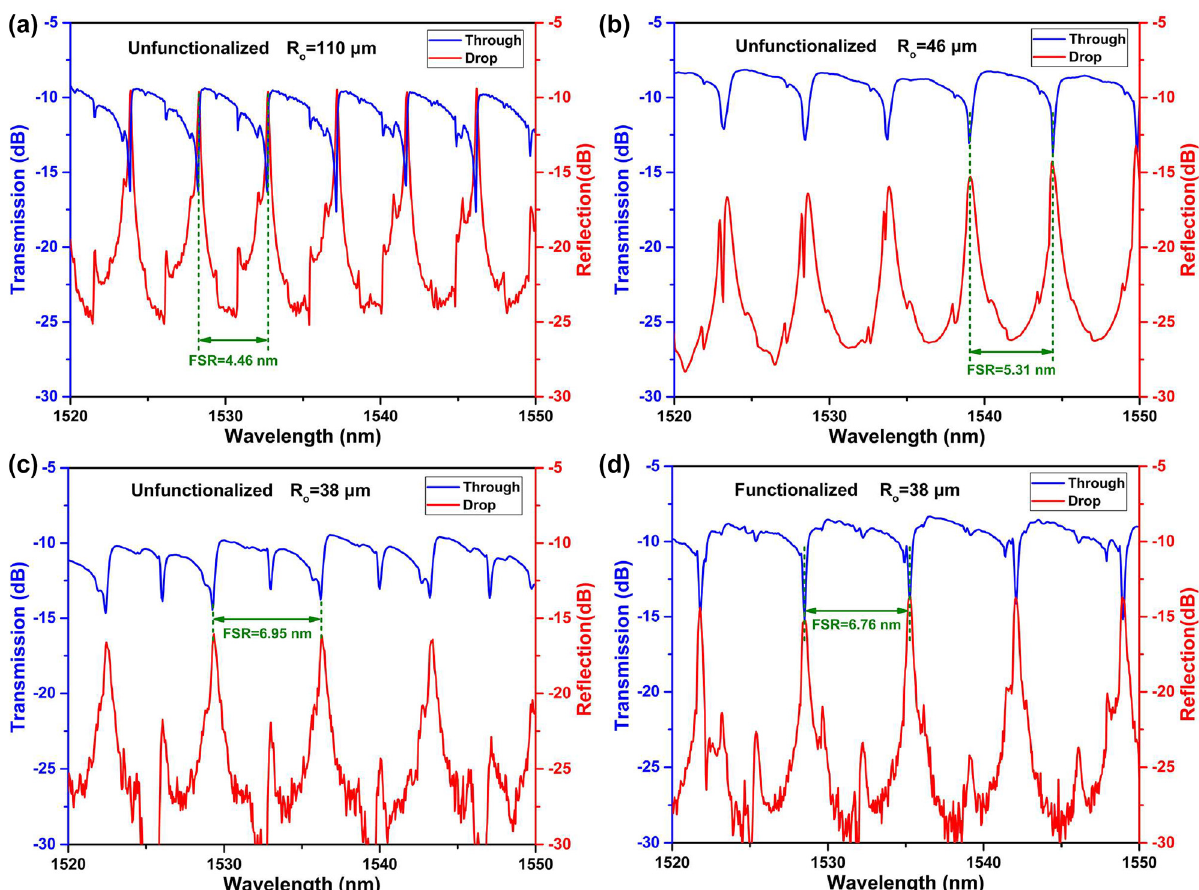
Figure 5: Excitation of WGM in double-fiber-coupled microtubule. Transmission and reflection spectra of the double-fiber-coupled microtubule cavities